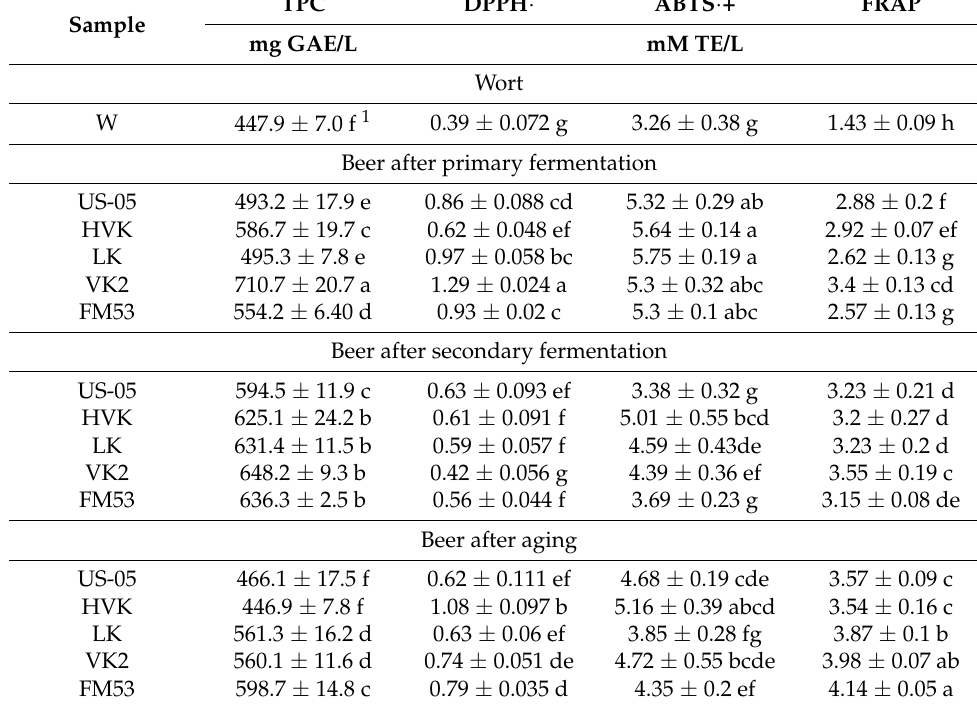
Table 3. Total polyphenol content and antioxidant activity of wort and